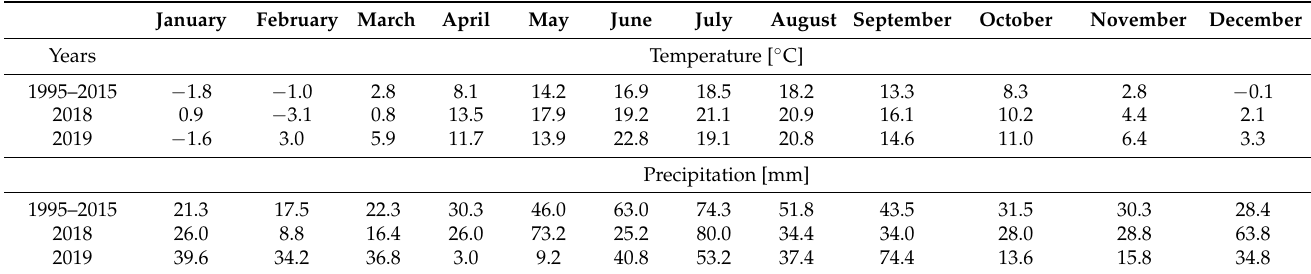
Table 3. Mean month air temperatures and a sum of month precipitations during the experiment compared with typical values calculated as multiannual averages based on archival data